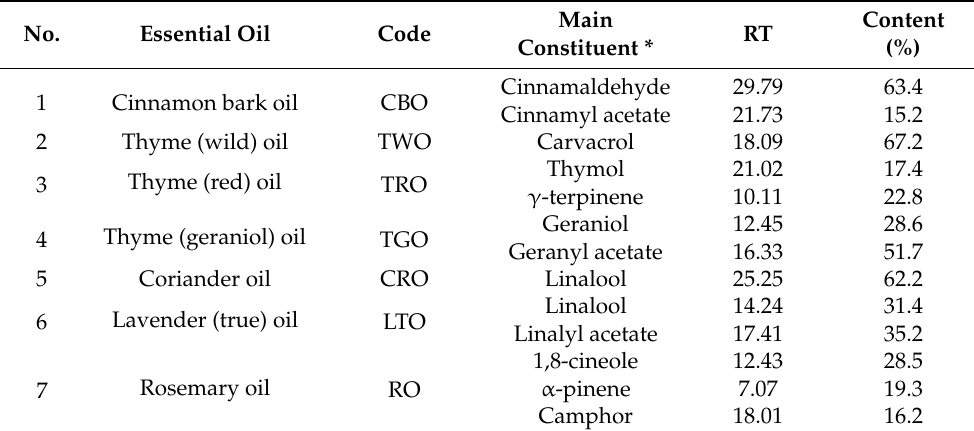
Table 3. Essential oils used and their major constituents.